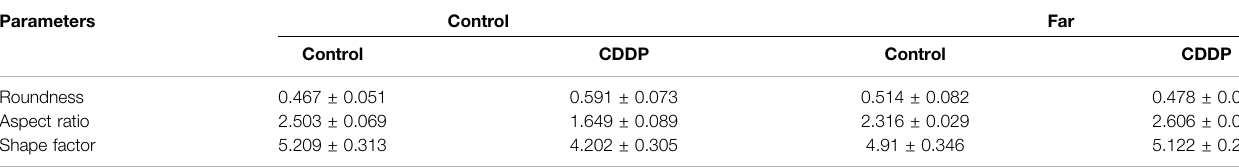
TABLE 1 | Contour measurements of mitochondria. Parameters Control Far Control